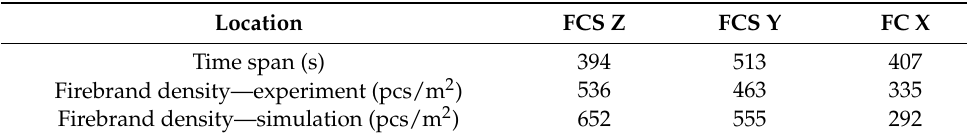
Table 9. The firebrand density of the experiment and